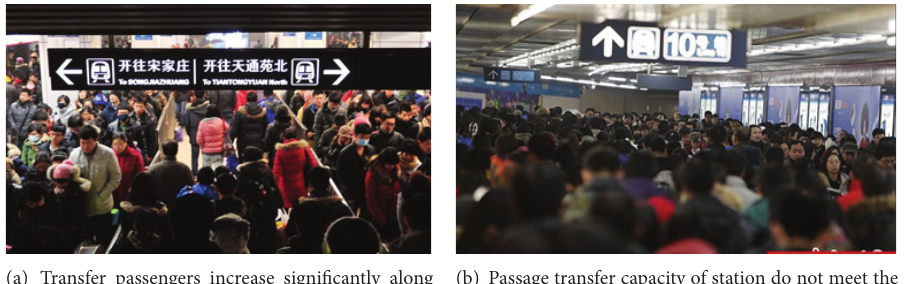
Figure 1: Overcrowding in subway transfer